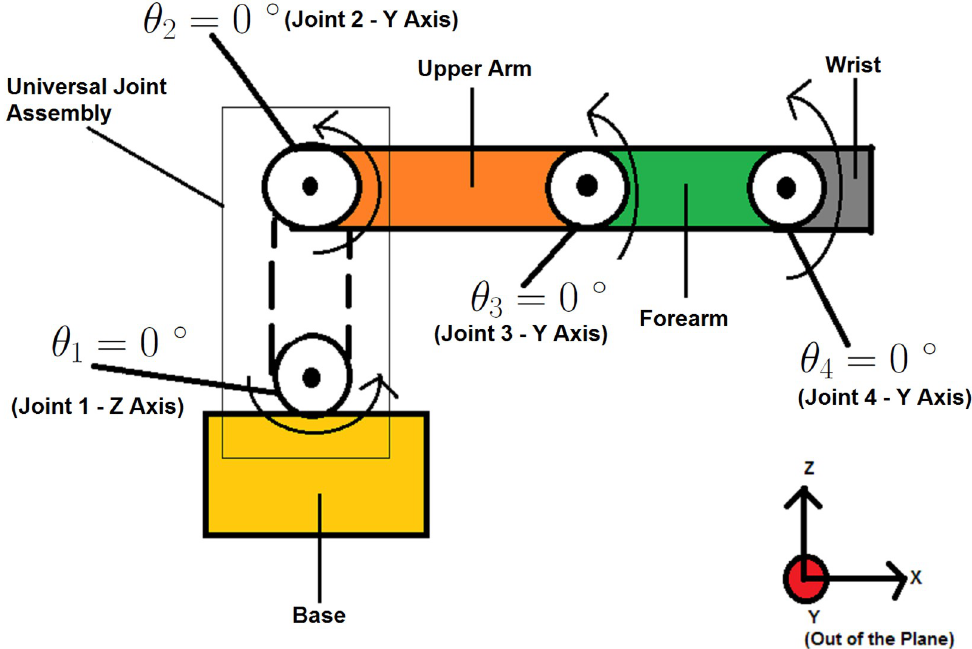
Fig 1. Home configuration of the robotic manipulator.